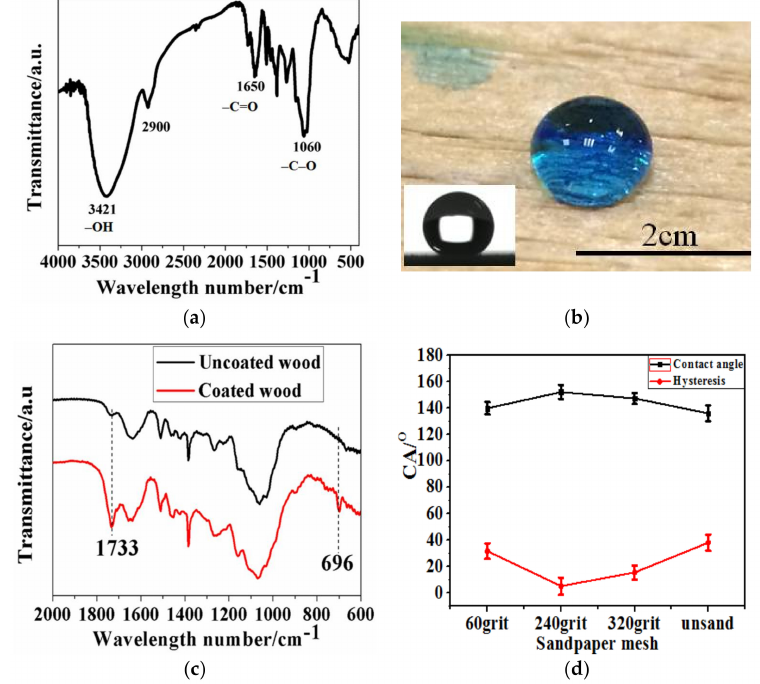
Figure 3. ( a ) FTIR spectra of the uncoated SR-240 wood; ( b ) Water contact angles (CAs) of the coated SR-240 wood; ( c ) FTIR spectra of the uncoated SR-240 wood and the coated SR-240 wood; ( d ) The effect of sandpaper mesh on water